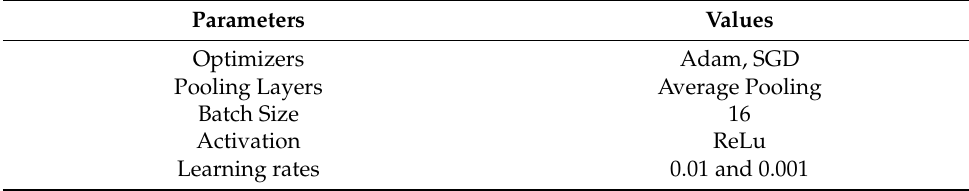
Table 2. Hyperparameters for the ship detection model.